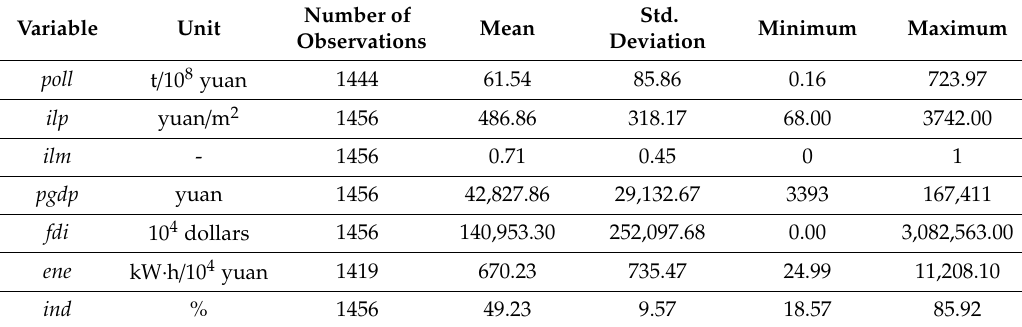
Table 1. Descriptive statistics of the variables used in the model.